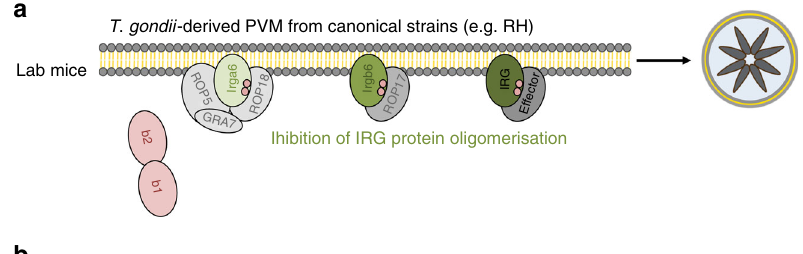
Fig. 6 T. gondii VAND-derived ROP5 escapes targeting by Irgb2-b1 CIM . a p(T108)Irga6 CIM protein intensities are increased at VAND-derived vacuoles. interferon- γ (IFN γ )-induced CIM diaphragm-derived cells (DDCs; 200 U ml − 1 ) were infected for 2 h with indicated T. gondii strains and individual p(T108) Irga6 CIM -positive vacuoles identi fi ed with 558 p(T108)Irga6 CIM -speci fi c antiserum. Error bars indicate the mean and SEM of three independent experiments. Kruskal – Wallis test followed by Dunn's multiple comparisons was used to test differences between groups; **** p < 0.0001; n.s. not signi fi cant. b Irgb2-b1 CIM intensities are reduced at VAND- and AS28-derived vacuoles. IFN γ -induced CIM DDCs (200 U ml − 1 ) were infected for 2 h with indicated T. gondii strains and individual Irgb2-b1 CIM -positive vacuoles identi fi ed with anti-Irgb2-b1-speci fi c antiserum. Error bars indicate the mean and SEM of three independent experiments. Kruskal – Wallis test followed by Dunn's multiple comparisons was used to test differences between groups; **** p < 0.0001; ** p < 0.006. c In vitro pull-down with recombinant GST-Irgb2-b1 CIM fusion protein and T. gondii tachyzoite detergent lysates. Pull-down of ROP5 by Irgb2-b1 CIM is reduced with AS28 and completely lost in case of VAND tachyzoite lysates compared to RH Δ hxgprt -derived ROP5 (middle left hand panel). VAND GRA7 pull-down is not dependent on ROP5 (lower panel). The upper panel indicates input of GST-Irgb2-b1 CIM in the pull-down. The right hand blot shows ROP5 (upper panel) and GRA7 (lower panel) levels in tachyzoite lysates. All tracks were run on a single gel; vertical white lines indicate excision of irrelevant tracks. d VAND ROP5 isoforms ROP5A, ROP5B1, ROP5B2 and ROP5B3 do not directly interact with Irgb2-b1 CIM or VAND GRA7 in a yeast two-hybrid approach. Proteins were expressed either as fusion to a transcriptional activation domain (AD) from pGAD-C3 or to a DNA- binding domain (BD) from pGBD-C3. Colony growth under 3DO conditions is indicative of protein/protein interaction. Bold black line separates samples from negative controls. e Upper panel, alignment of T. gondii RH and VAND ROP5 amino acid sequences that represent a polymorphic hotspot and have been shown to be involved in binding to Irga6 BL/6 . Polymorphic sites are highlighted in blue. Lower panel, phylogenetic analysis and maximum likelihood tree of T. gondii RH and VAND rop5 sequences. Only maximum likelihood bootstrap values above 50 are shown